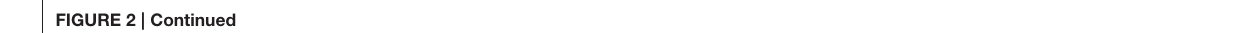
Frontiers in Physiology |